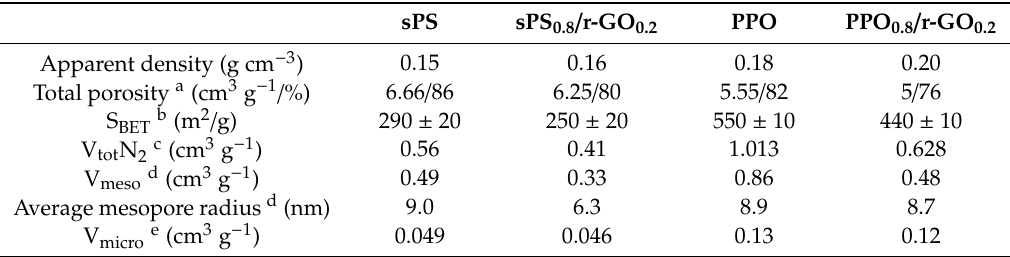
a Total porosity estimated from the volume / mass ratio expressed as cm 3 · g − 1 and % using Equation (1). b Total area